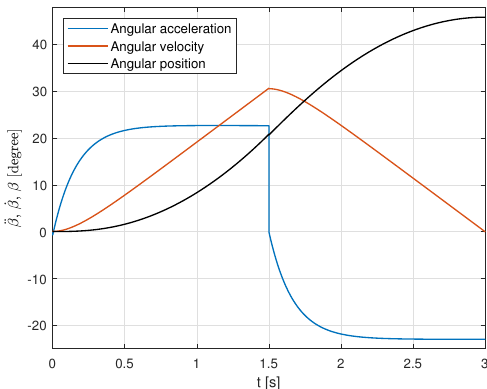
Figure 2. Appendage time history.